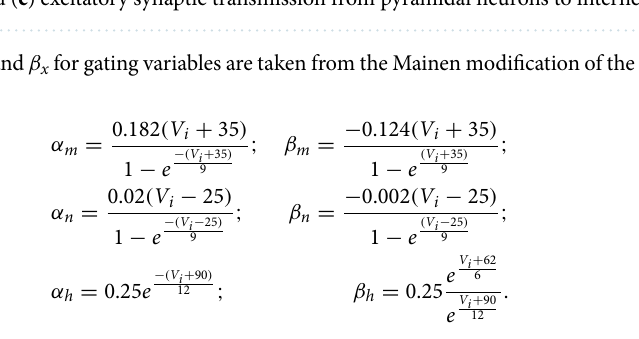
Figure 1. ( a ) A scheme illustrating the organization of modeled BCs-pyramidal cells-astrocytes network in hippocampal area CA1 55 . ( b , c ) Architecture of the neuron-astrocyte network model. The interneuron network model consists of 200 neurons arranged on a virtual ring 15 , which mimics the organization of the basket cell network. Each neuron is randomly connected to its 100 nearest neighbors by inhibitory chemical synapses with a probability of 0.5. Interneurons receive excitatory inputs from pyramidal neurons whose stochastic firing is triggered by the random Poisson spike trains. Astrocytes are organized in a ring-shaped network repeating the topology of the interneuron network. Each astrocyte in the proposed model is connected to the neighboring astrocytes through gap junctions. Two types of astrocytic influence on signal transmission in the neuronal network are considered: astrocyte-induced modulation of ( b ) inhibitory synaptic transmission in the interneuron network and ( c ) excitatory synaptic transmission from pyramidal neurons to